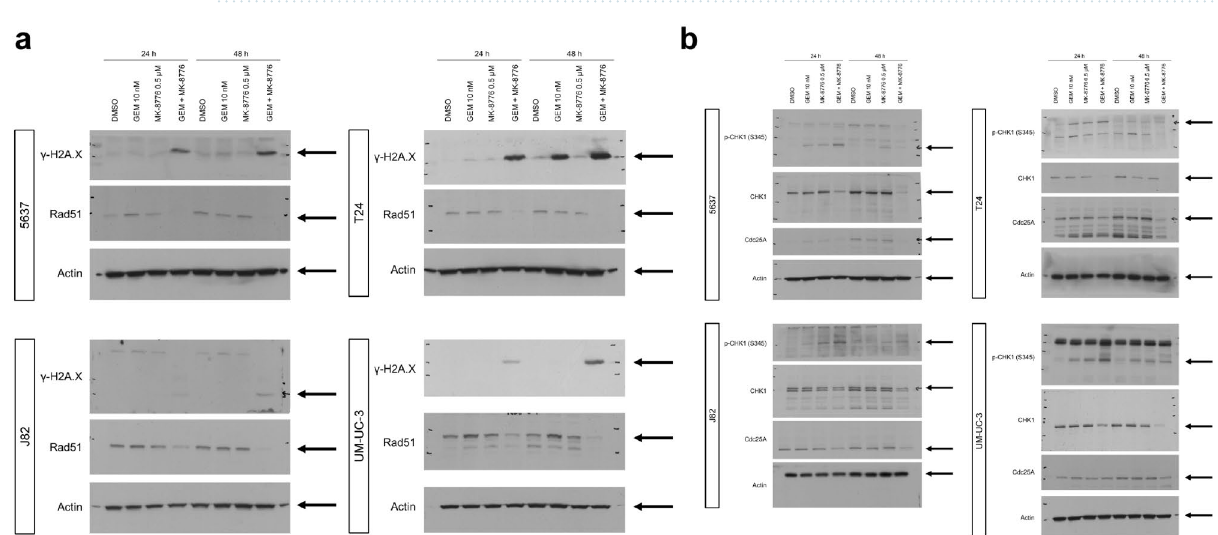
Figure 4. Western blot analysis of checkpoint factors. ( a ) γH2A.X and Rad51 protein expression following the indicated treatment. Actin was used as a loading control. A quantification of the signals is illustrated in Fig. S6. ( b ) Expression of cell checkpoint-related proteins and their phosphorylation in whole-cell lysates. Actin was used as a loading control. A quantification of the signals is illustrated in Fig.